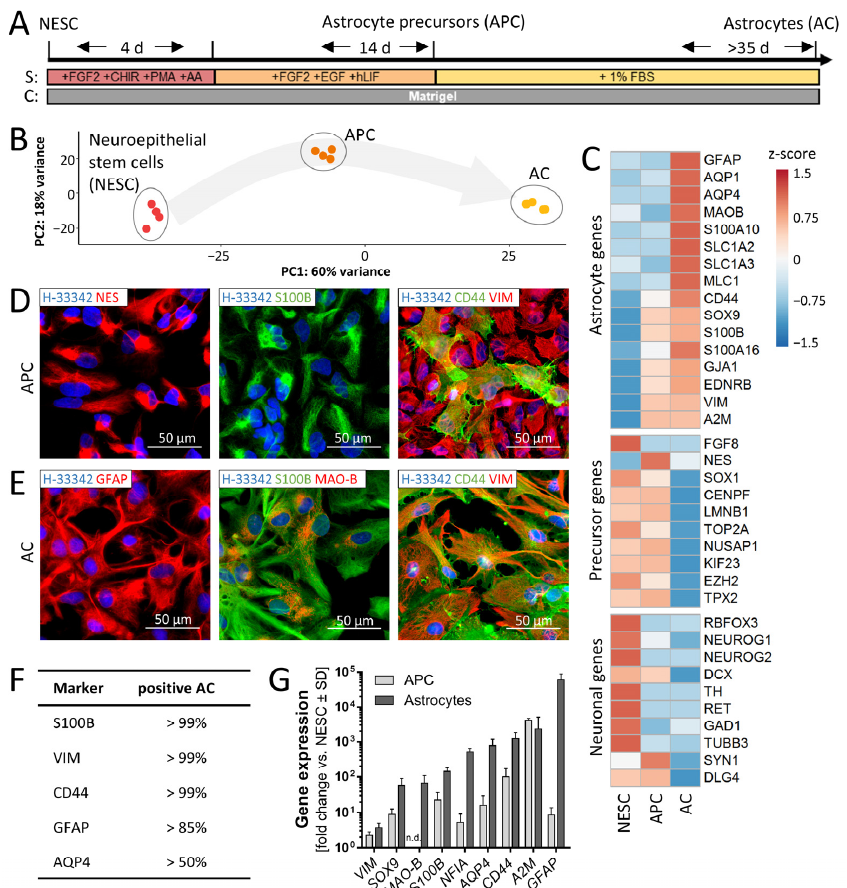
Figure 1. Generation and characterization of human astrocytes. ( A ) Schematic differentiation of astrocytes (ACs) from neuroepithelial precursor cells (NESCs) via astrocyte precursor cells (APCs). NESCs were thawed and differentiated to APCs in two steps. For the first four days, the medium contained fibroblast growth factor (FGF2), the Wnt activator (CHIR99021), the smoothened receptor agonist purmorphamine (PMA) for activation of the hedgehog pathway and the antioxidant ascorbic acid (AA) as supplements (S). In the second phase (14 d), the medium was supplemented with FGF2, epidermal growth factor (EGF) and human leukemia inhibitory factor (hLIF). APCs were differentiated towards ACs with 1% fetal bovine serum (FBS) as medium supplement. ACs were considered mature after at least 35 days of differentiation from APCs. ( B ) The gene expression of NESCs, APCs and ACs was quantified for a panel of 3562 genes (four samples each). In the 2-dimentional display of the principal component analysis (PCA), the axes are scaled according to the variance explained by the respective PCA component. ( C ) Heat map depicting the row-wise z-scores of expression levels of selected marker genes in NESCs, APCs and ACs. Data are derived from mean expression levels (in counts per million reads) with n = 4. ( D ) APCs were fixed and immunostained for typical astrocyte precursor markers: nestin (NES), S100B, CD44 and vimentin (VIM). Nuclei were counterstained with the DNA stain Hoechst-33342 (H-33342). ( E ) Mature ACs were fixed and immunostained for typical astrocyte markers: GFAP, S100B, monoamine oxidase B (MAO-B), CD44 and vimentin (VIM). Nuclei were stained with H-33342 (blue). Representative epifluorescence images of typical expression patterns and morphologies are shown in ( D , E ). Pseudocoloring of antigens is indicated in image legends. ( F ) Quantification of the percentage of marker-positive ACs after ≥ 35 d. Three independent AC differentiations were used for imaging and three fields per differentiation were scored. Cells (70/field) were randomly picked in the H-33342. ( G ) AC marker expression was confirmed by RT-qPCR gene expression analysis in APCs (14 d) and ACs (35 d). Data are means ± SD of ≥ 3 independent differentiations. Gene expression data (RT-qPCR) for later time points of AC differentiation can be found in Figure S1A. n.d., not